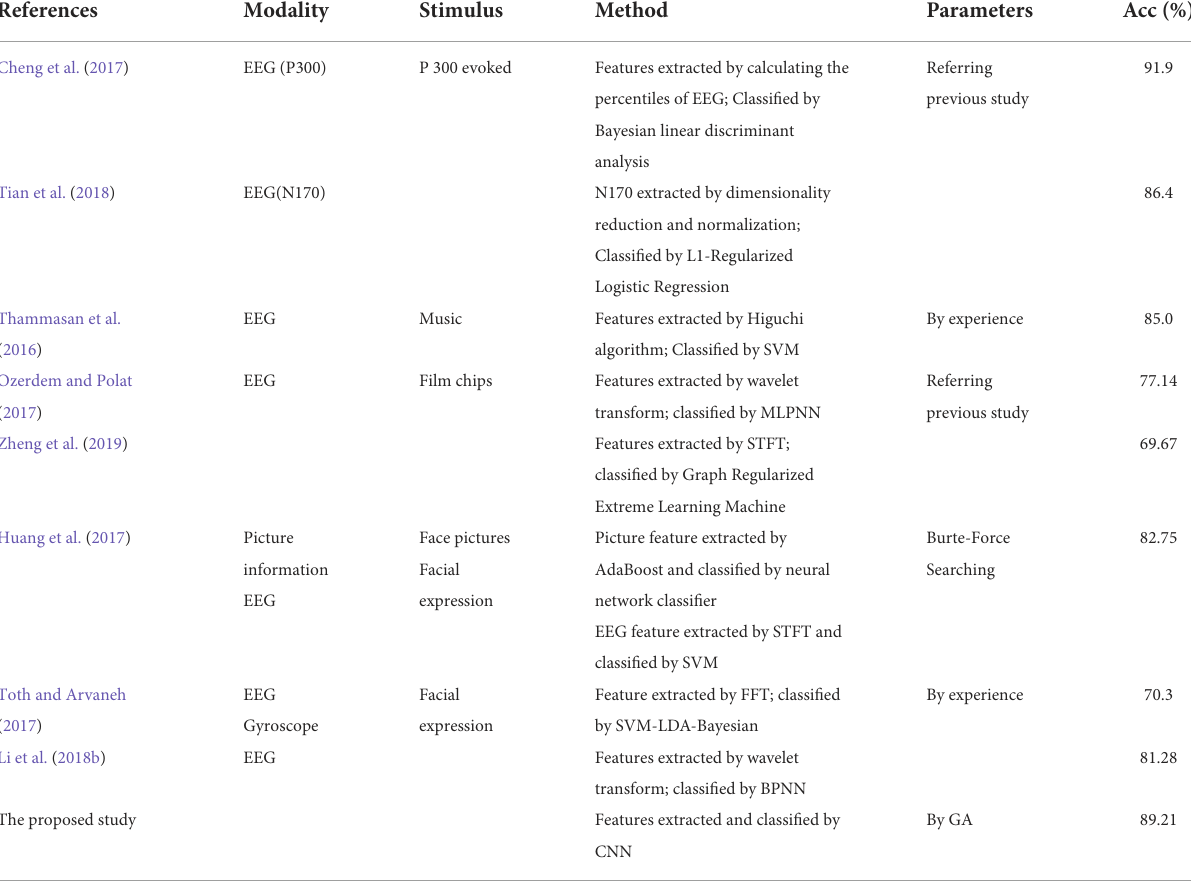
TABLE 5 Performance comparison of previous work based on the